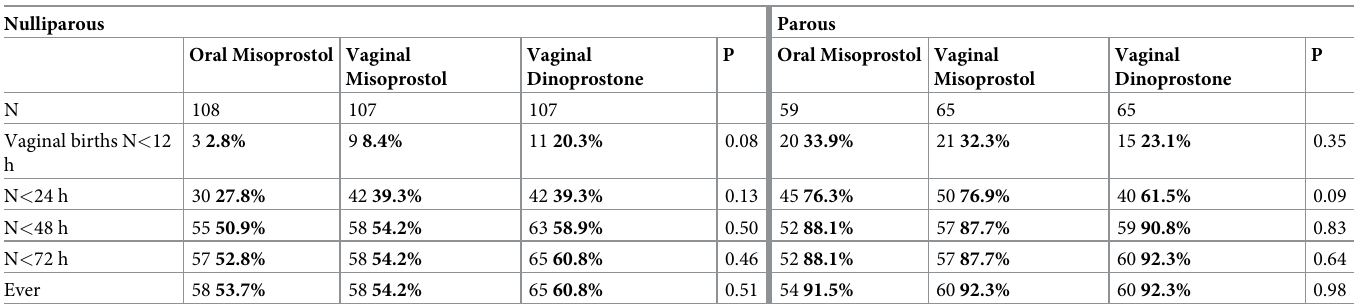
Table 6. Vaginal births achieved within specific times, by parity.